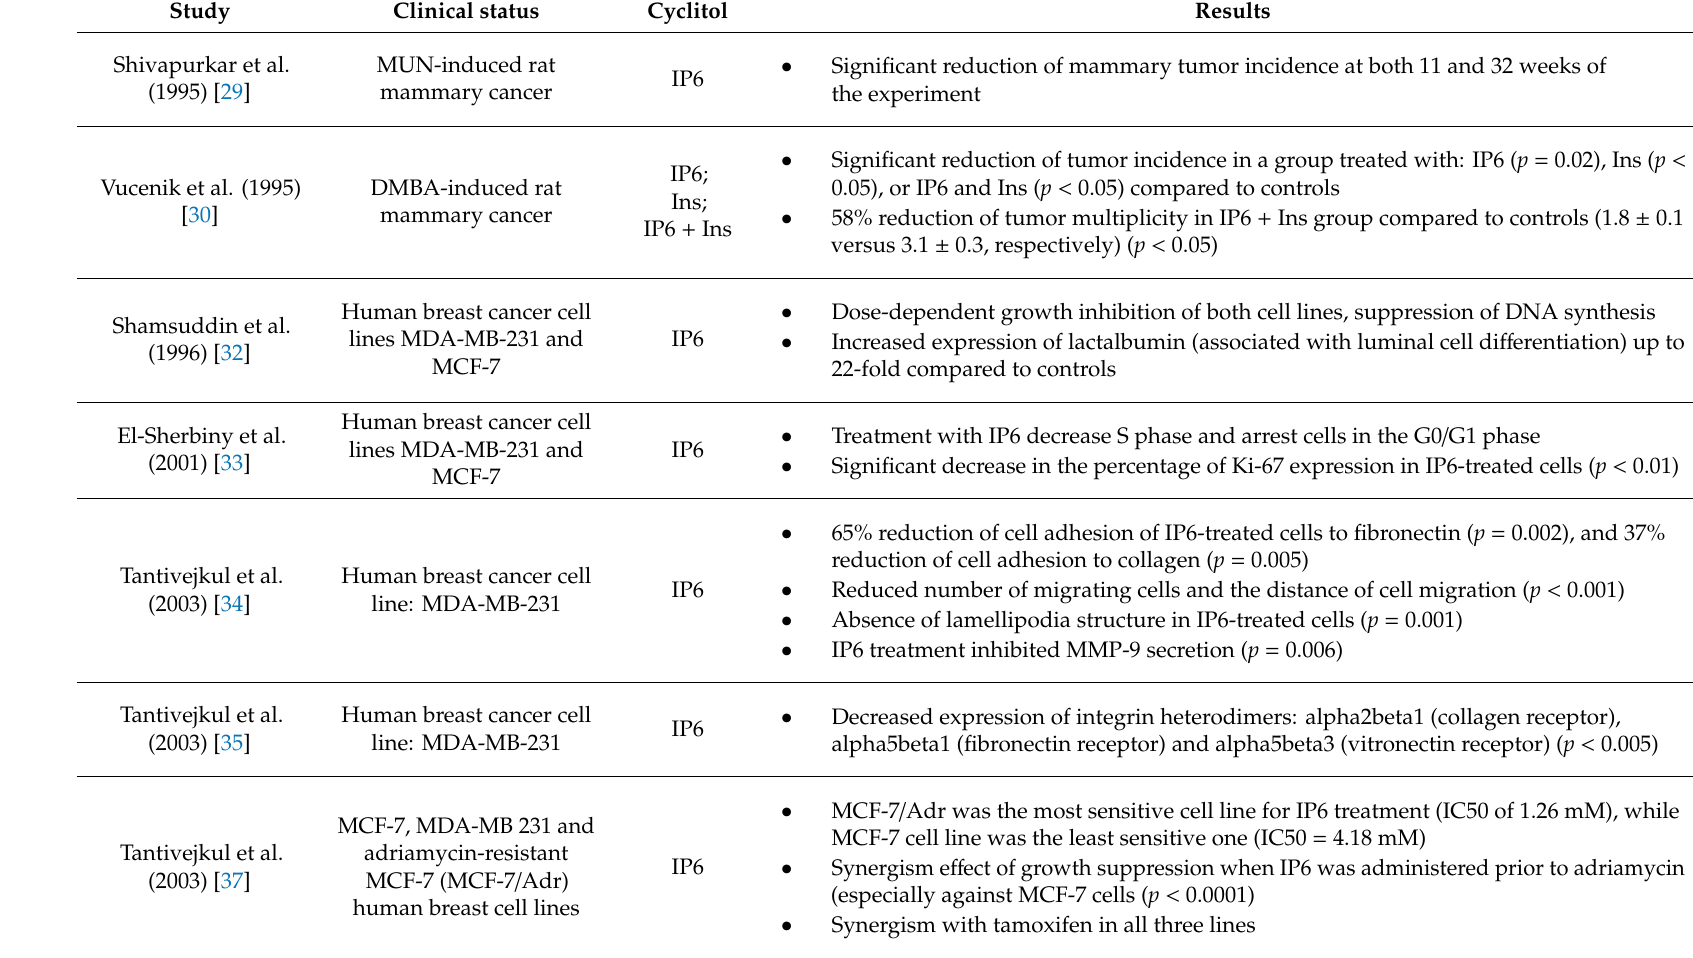
Table 2. Antineoplastic activity of cyclitols in breast